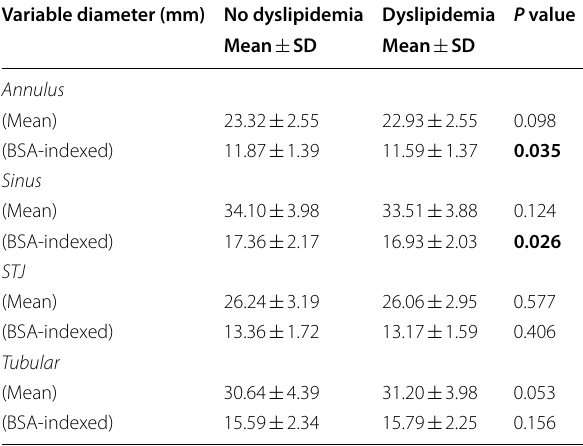
Bold mean significant values that is less than or equal 0.05